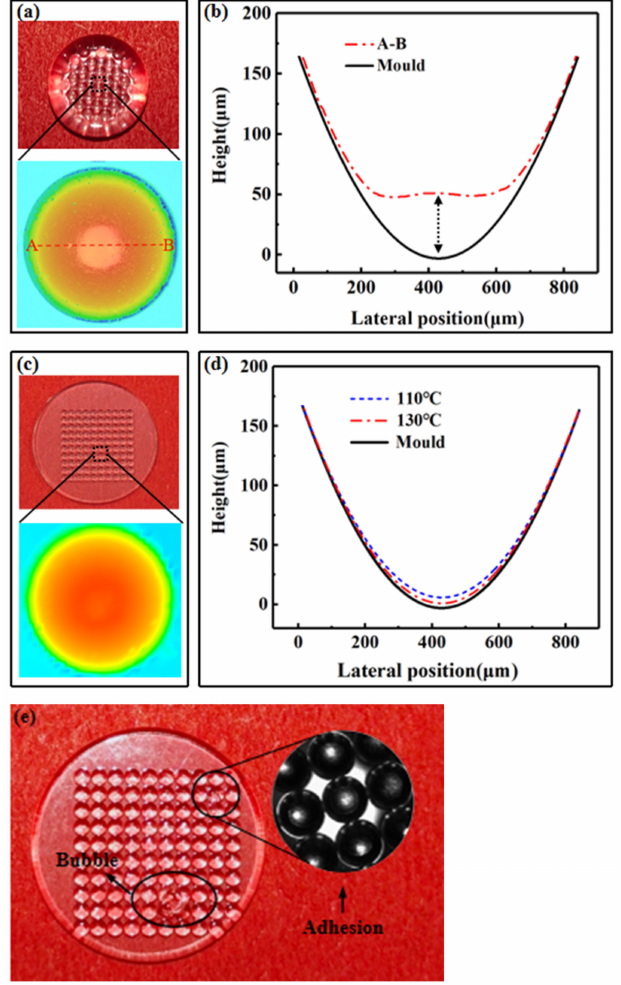
Figure 4. ( a ) Aspheric microlens array image at a molding temperature of 100 ◦ C, ( b ) the comparison of aspheric microlens profile and mold profile at a molding temperature of 100 ◦ C, ( c ) aspheric microlens array image when the temperature is 130 ◦ C, ( d ) the comparison of the aspheric microlens profile and mold profile when the molding temperature is 110 ◦ C/130 ◦ C, and ( e ) the surface of the aspheric microlens array with bubbles when the molding temperature is 150 ◦